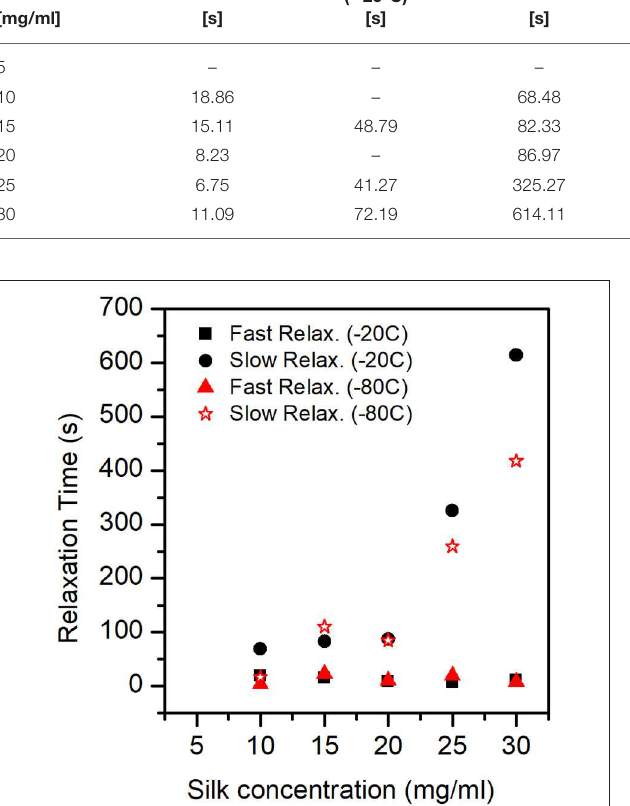
FIGURE 10 | Relaxation Times (Fast mode and Slow mode) for the different sponges. In the ANOVA analysis we found that only the slow relaxation was significantly affected by silk concentration ( p -value = 0.07, F -value = 19.35) and not by the process temperature ( p -value = 0.287, F -value = 1.51). The fast relaxation was independent of concentration and process